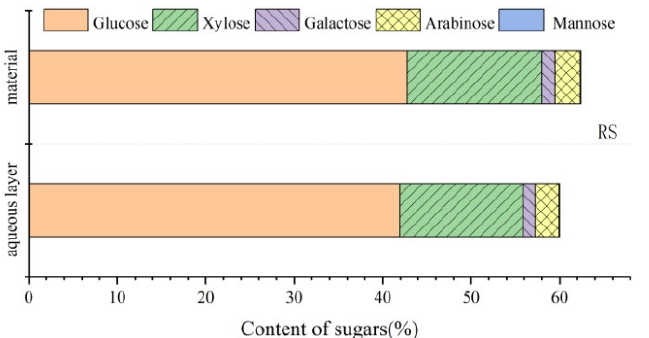
Figure 11. Analysis of carbohydrate content of rice straw before and after phase separation. Table 9. Carbohydrate compositions in the aqueous flour after phase separation. Carbohydrate